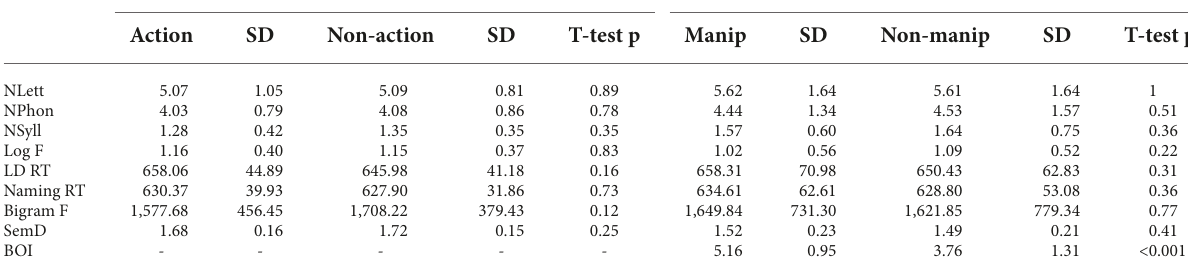
TABLE 2 Characteristics of the words used in the semantic similarity judgment task. Verbs Nouns